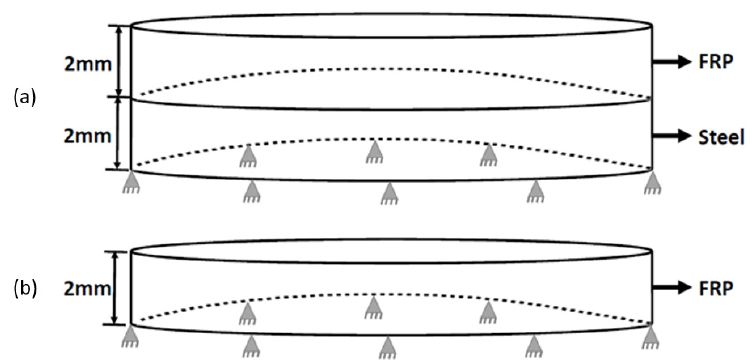
Figure 5. Imposed mechanical boundary conditions for ( a ) FRP/steel hybrid and ( b ) FRP samples.